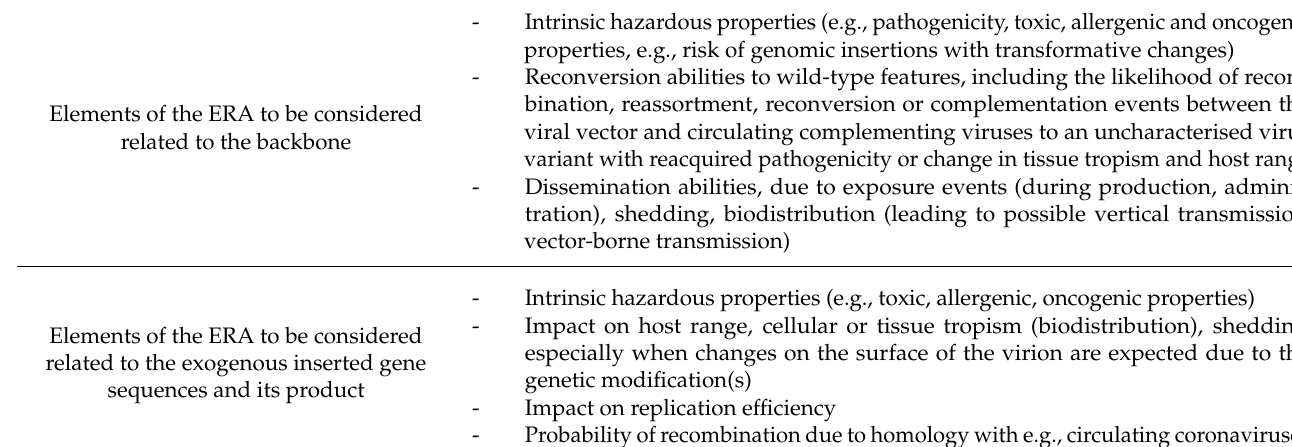
Table 2. Elements related to viral vector based vaccines against SARS-CoV-2 to assess in context of an environmental risk assessment